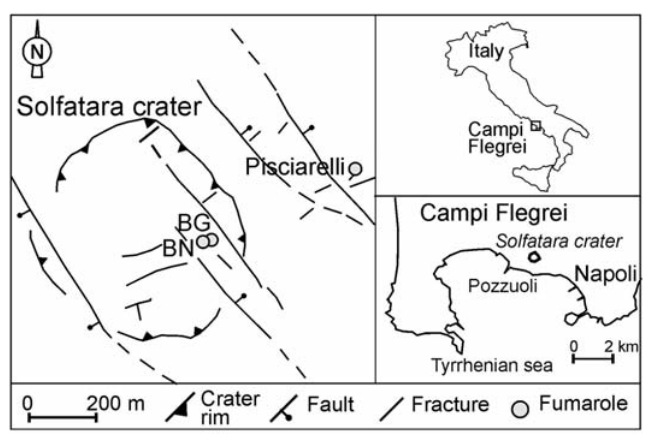
Figure 1. Location map and main geological features of the Solfatara crater, showing the Bocca Grande (BG), Bocca Nuova (BN) and Pisciarelli